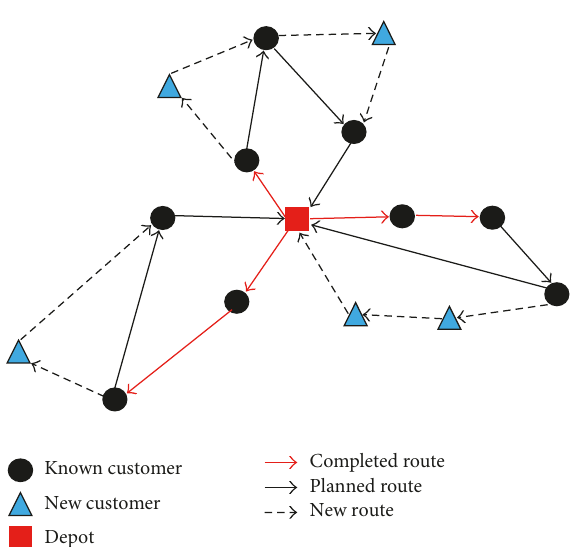
Figure 1: A three-vehicle DVRP with 5 unknown customer